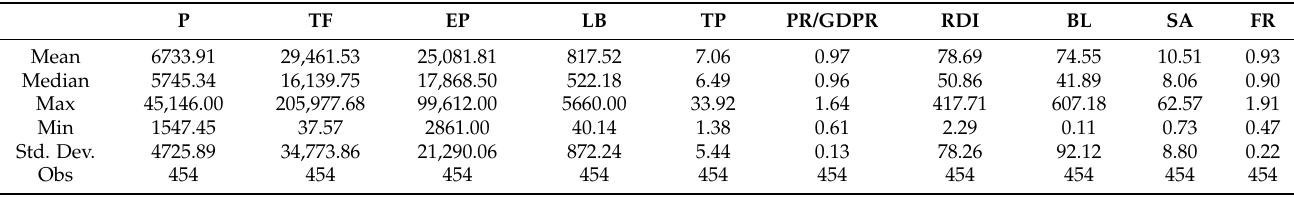
Table 2. The descriptive statistical analysis results of